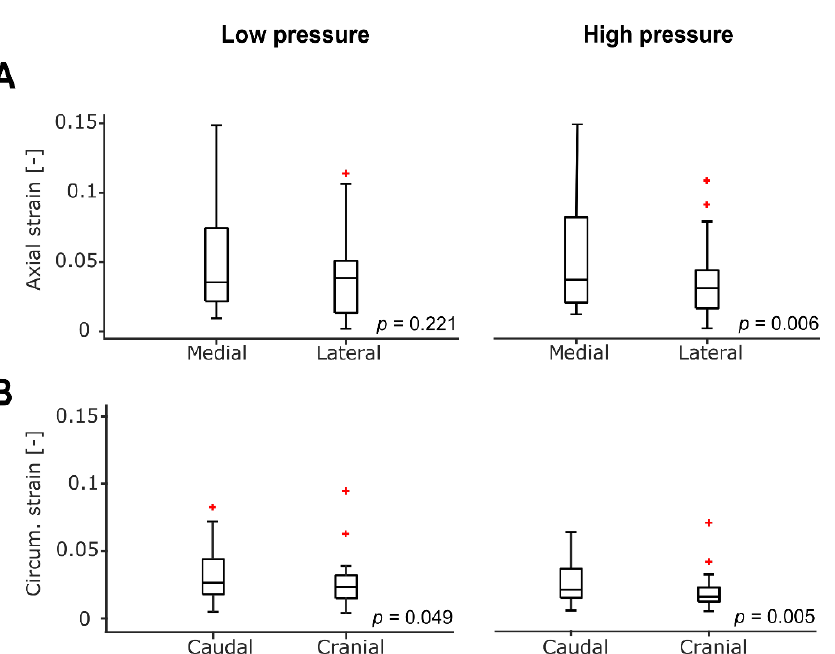
Figure 2. Potential for detecting local strain differences. p -values indicate paired Wilcoxon Signed Ranks testing, with n = 30 for low and n = 29 for high pressure. Boxplots indicate medians [25th, 75th percentile], with whiskers indicating variability beyond the first and the third quartile, while red plus signs are the outliers. ( A ): Lateral axial strains tended to be lower than those captured medially, but only achieving statistical significance in the high-pressure condition. ( B ): Cranial circumferential strains tended to be significantly lower than at the caudal location. Note: one outlier not shown in B (values for caudal and cranial strains > 0.2 for both pressure conditions).